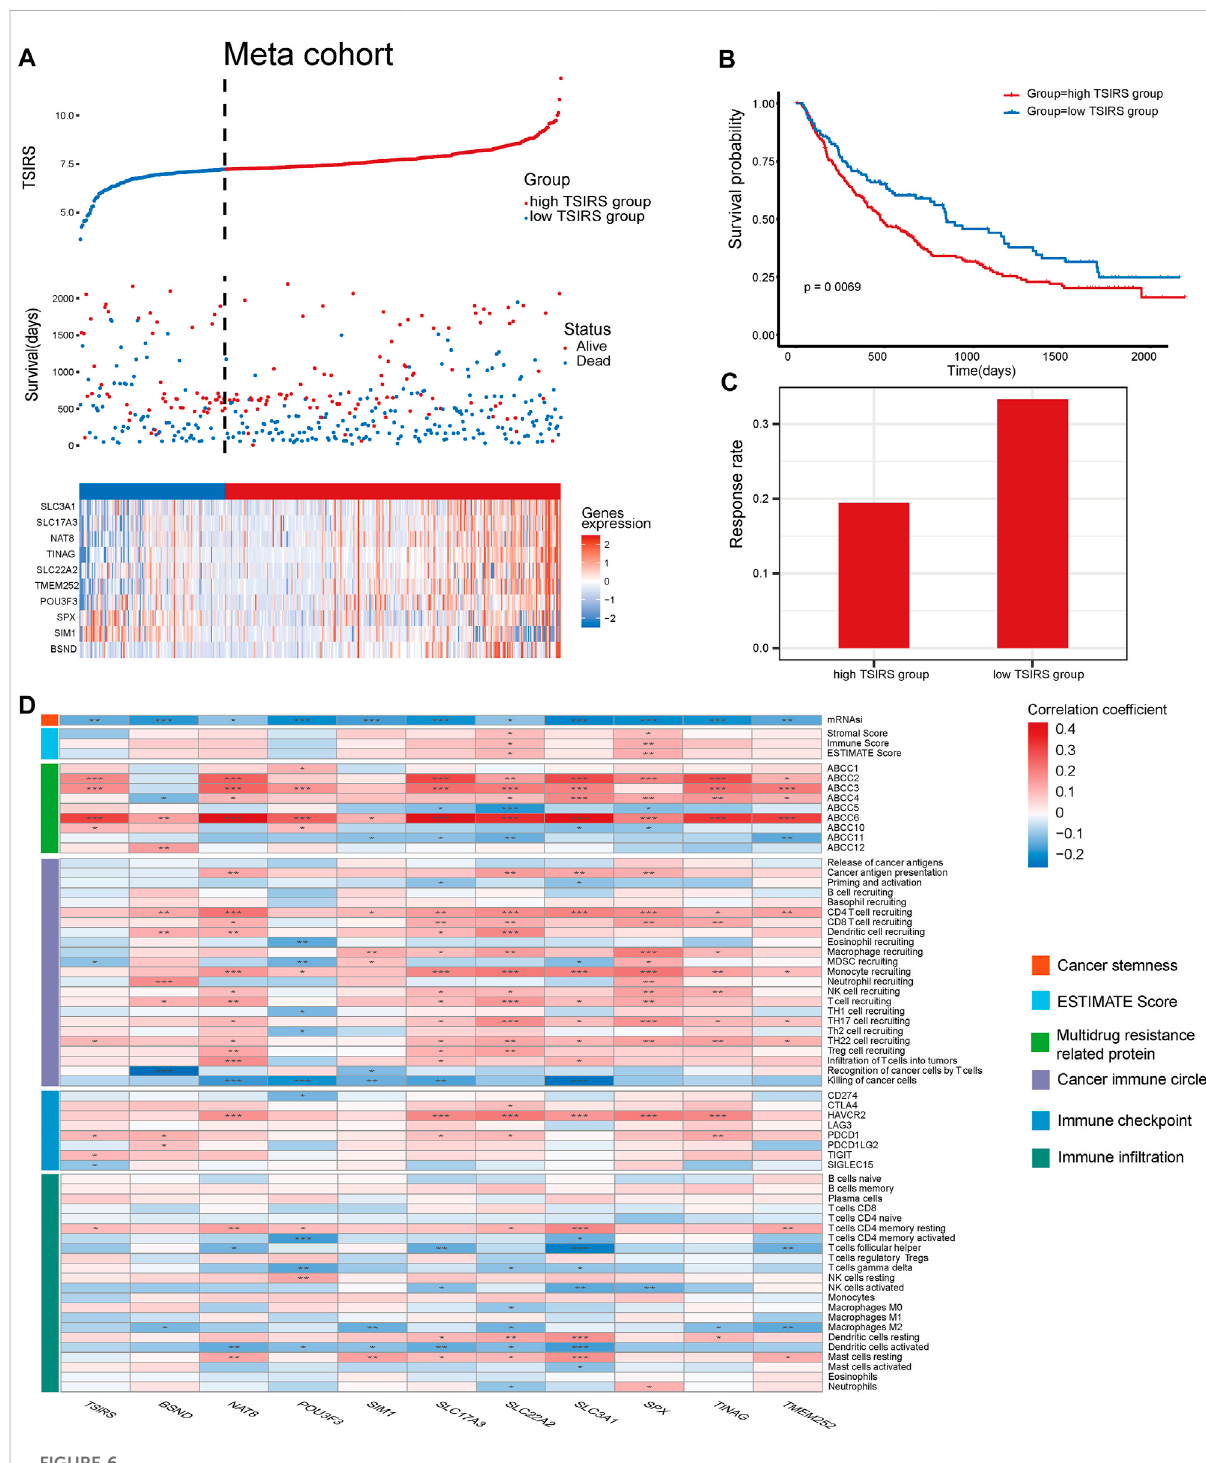
FIGURE 6 TSIRS predicts prognosis and microenvironment characteristics of patients during anti-PD1/PDL1 treatment, (A) Distribution of the high TSIRS groupandthelowTSIRSgroupinmetacohort. (B) ComparisonofpatientprognosisofthehighTSIRSgroupandthelowTSIRSgroupinmetacohort. (C) Patient therapy responsiveness rate of the high TSIRS group and the low TSIRS group in meta cohort. (D) Correlation between TSIRS and cancer stemness, ESTIMATE Score, expression level of genes coding multidrug resistance related protein, cancer immune circle related pathway activity, immune checkpoint expression and immune in fi ltration level. * p < 0.05, ** p < 0.01, *** p <